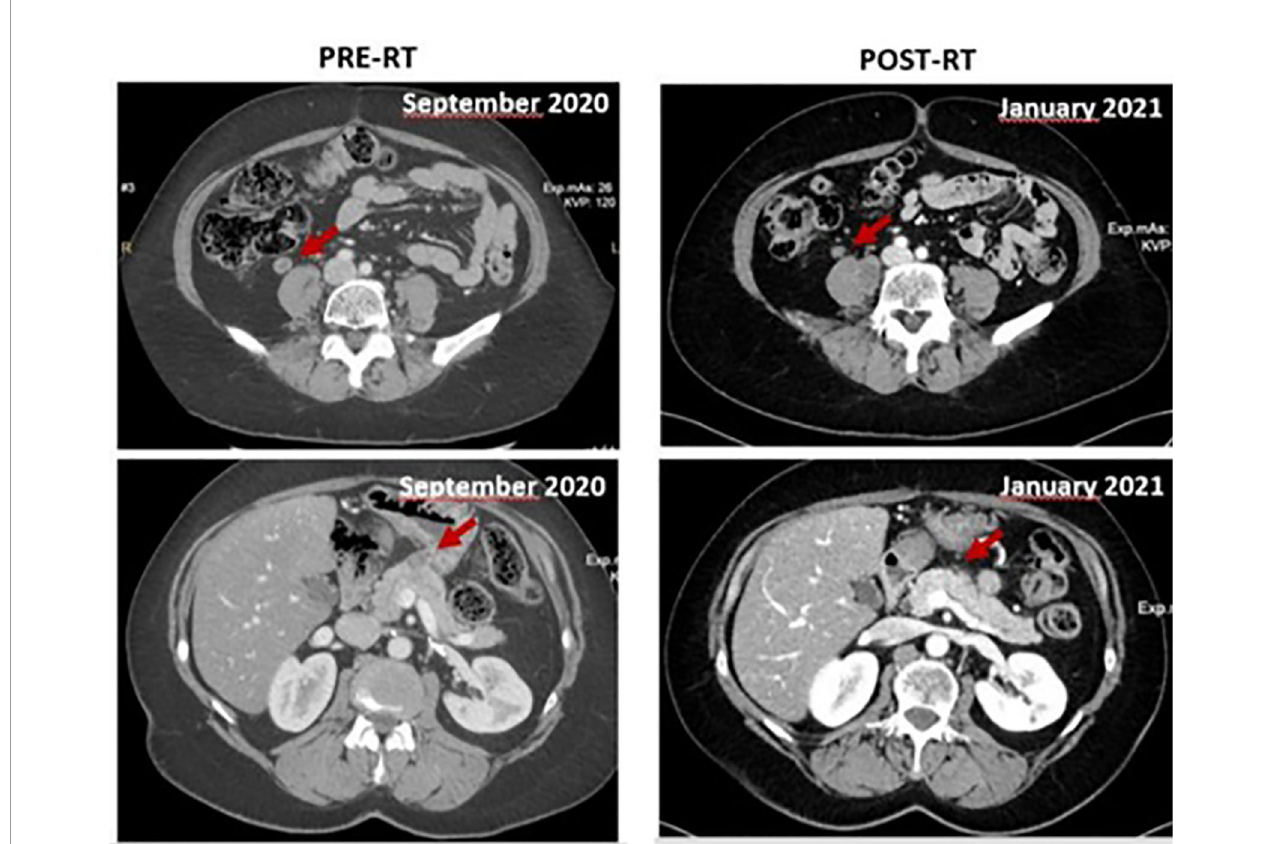
FIGURE 4 | Comparison between September 2020 (on the left, pre-RT) and January 2021 (on the right,